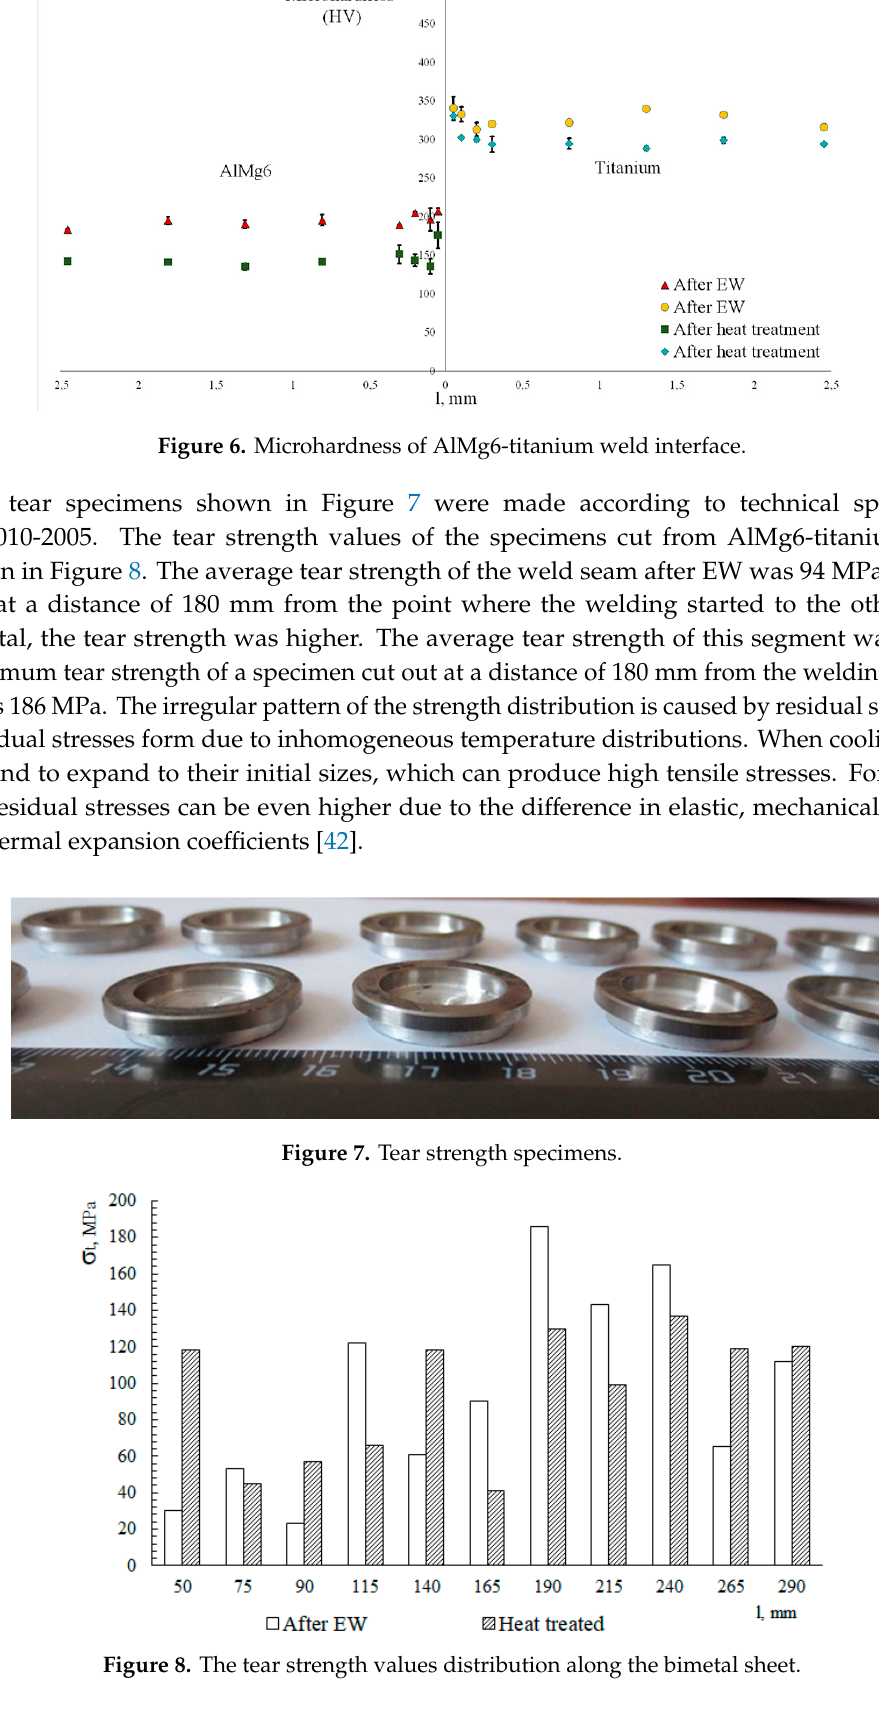
Figure 5. SEM micrographs: ( a ) the weld interface beside the welding point; ( b ) the weld interface of the other edge of the bimetal.